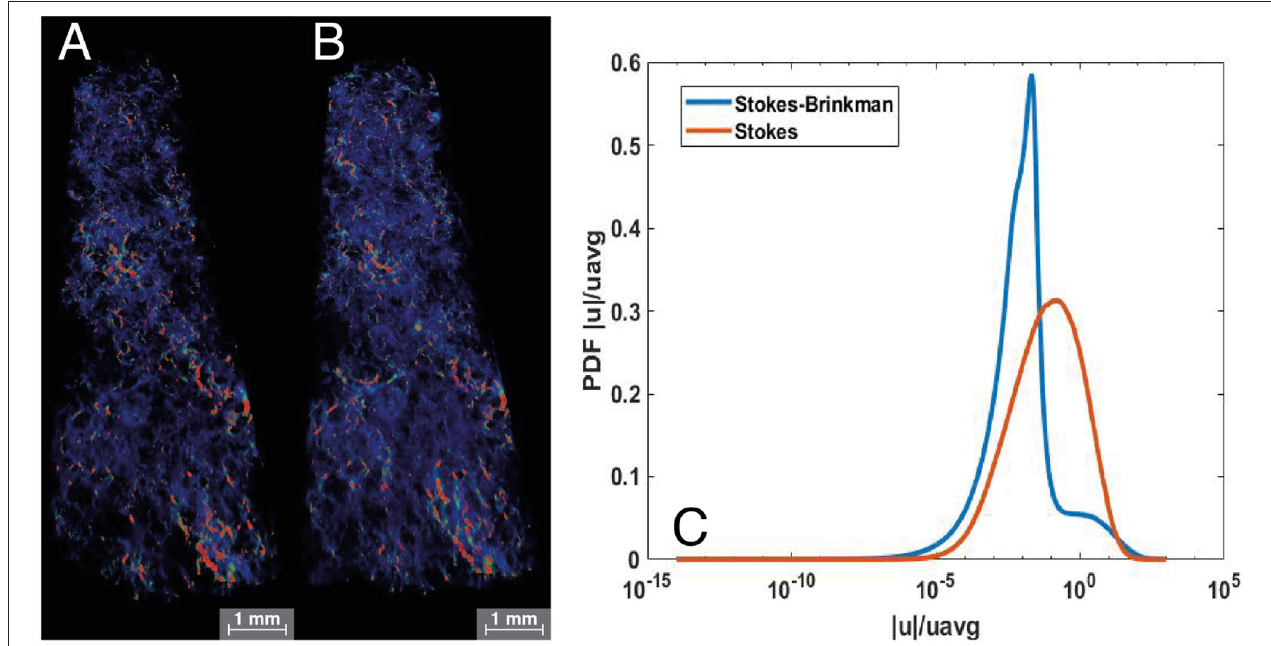
FIGURE 13 | Velocity fields rendered with high velocities in red and low velocities in blue for Stokes (A) and S–B simulations (B) . The PDFs of velocity (C) are shown for Stokes (red) and S–B (blue) simulations.